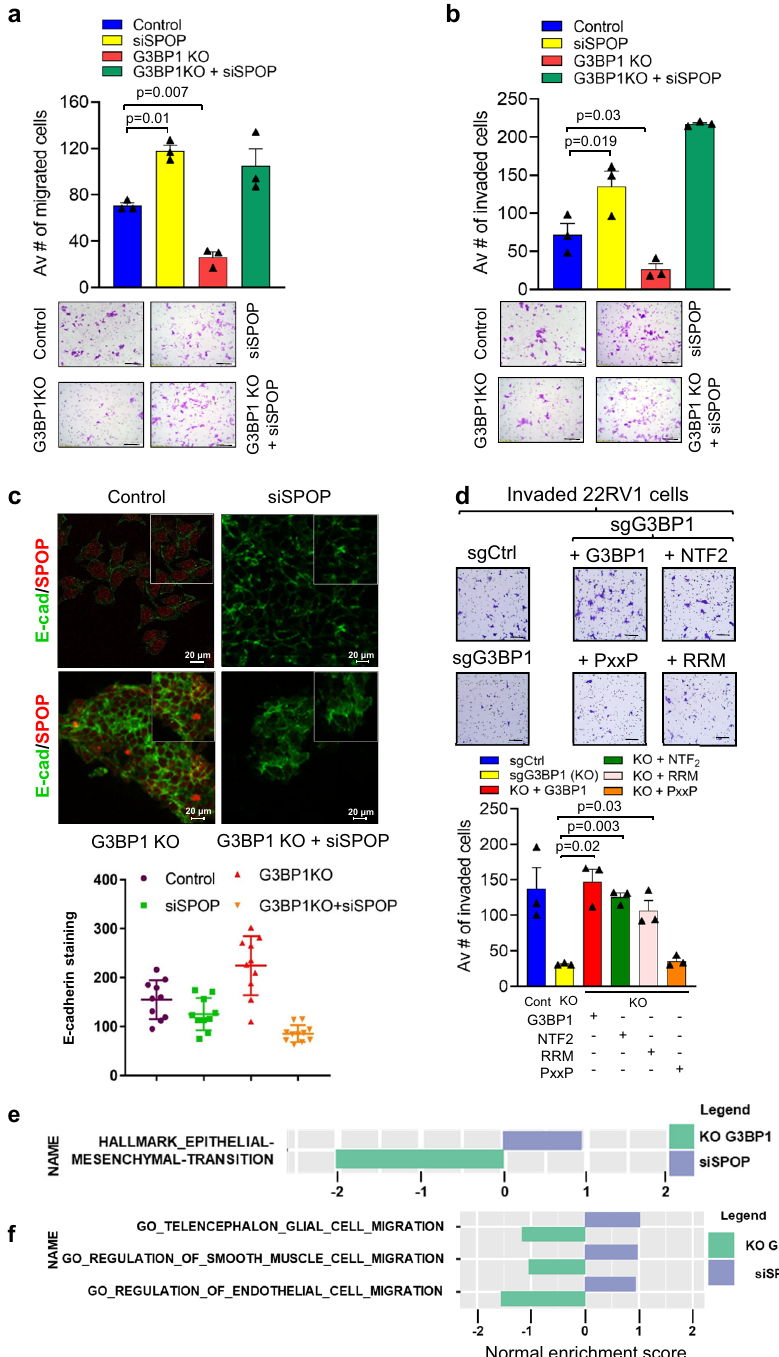
Fig. 6 G3BP1-SPOP ubiquitin signaling axis controls migratory and invasive potential of prostate cancer cells. a , b 22Rv1-sgCtrl or 22Rv1-sgG3BP1 cells were transfected with non-targeted or SPOP siRNA and designated as Ctrl, siSPOP, G3BP1 KO (sgG3BP1), and G3BP1 KO + siSPOP (sgG3BP1 - siSPOP). Quanti fi cation and representative images (×10 magni fi cation) of a migrated and b invaded cells. Error bars, ±S.E.M. n = 3 biologically independent experiments. Paired t -test ( c ) representative immuno fl uorescence images of E-cadherin expression in 22Rv1 cells. scale bar, 20 µ m. Quanti fi cation of E-cadherin staining represented as arithmetic mean intensity. n = 3 biologically independent experiments. Error bars, ±S.E.M. d Representative images (×10 magni fi cation) of invasive 22Rv1-sgG3BP1 cells transfected with the indicated G3BP1 constructs in matrigel invasion assays. Quanti fi cation of data averaged on n = 6 biologically independent experiments. Error bars, ±S.E.M. Paired t -test. p value is indicated in fi gure. e , f GSEA analysis of G3BP1 KO and siSPOP cells compared to control samples based on epithelial and mesenchymal transition-related signatures ( e ), and migration-related signatures ( f ). Source data are provided as a Source Data fi